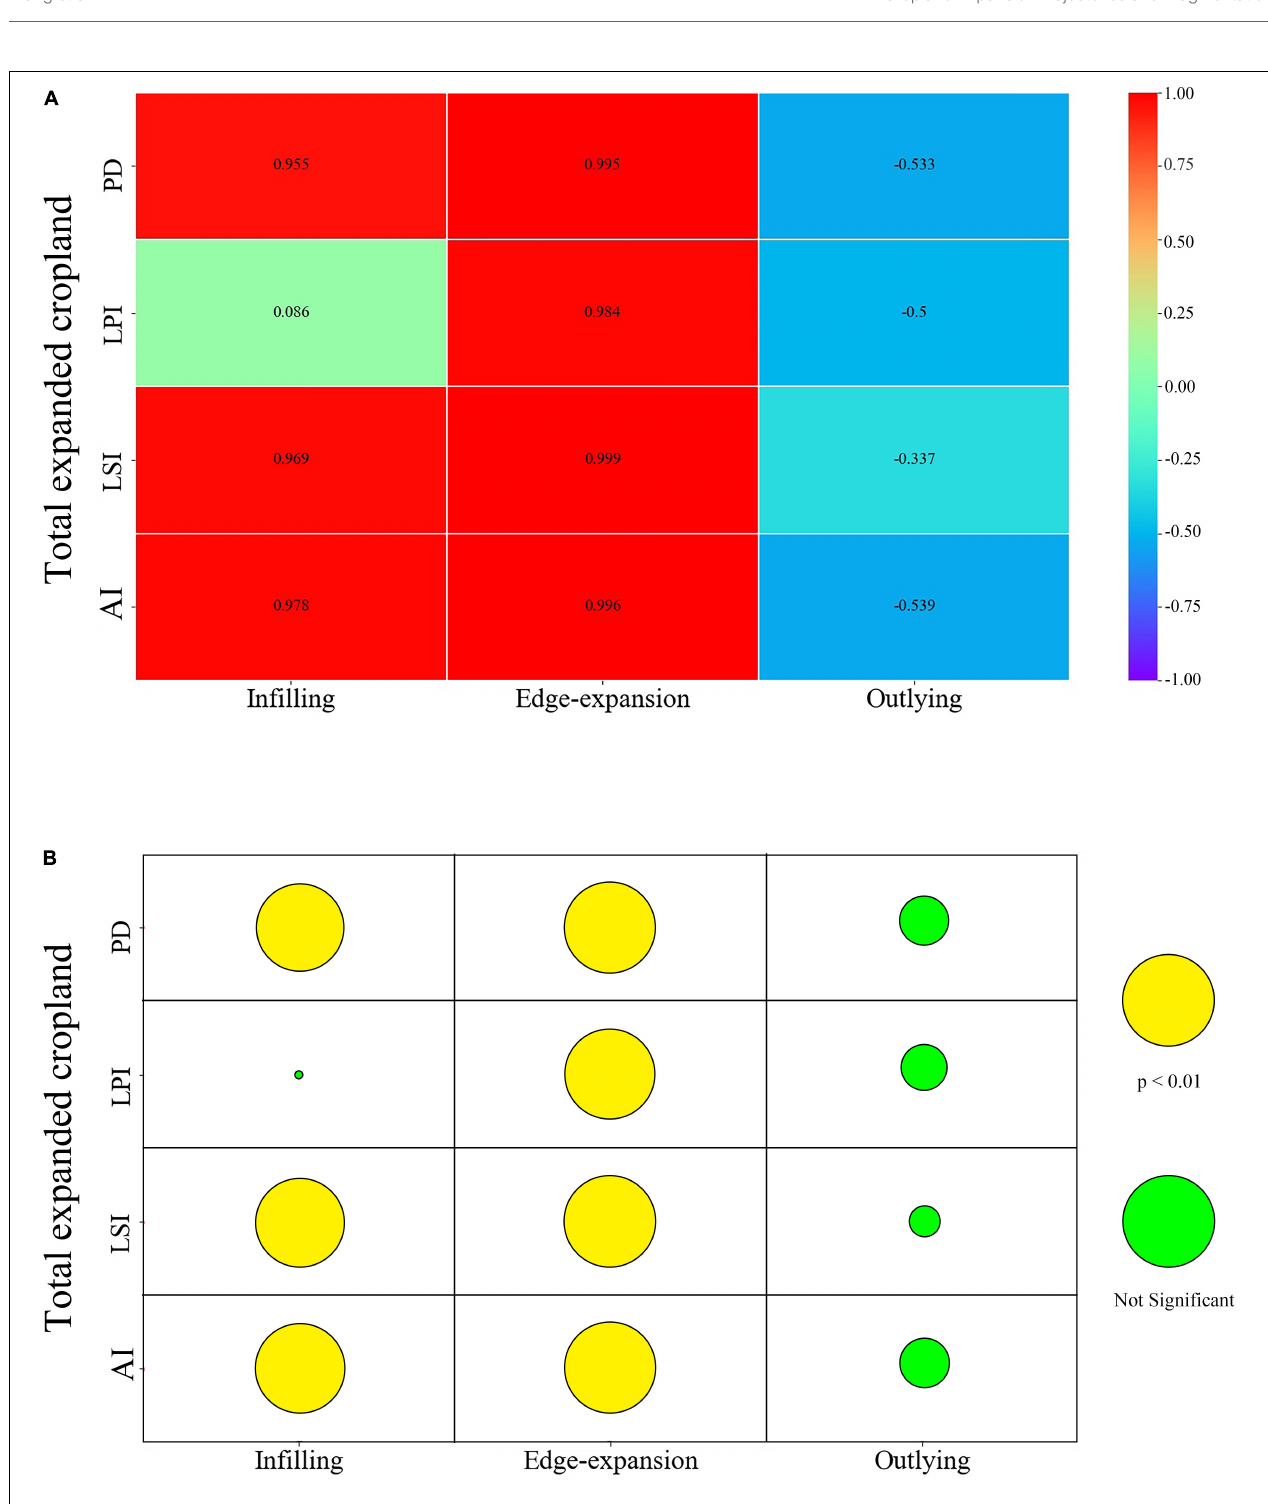
FIGURE 8 | Correlation coefficients of landscape metrics between the total expanded cropland and cropland trajectories (A) and significant degrees (B) . The size of circles represents the size of correlation coefficients.